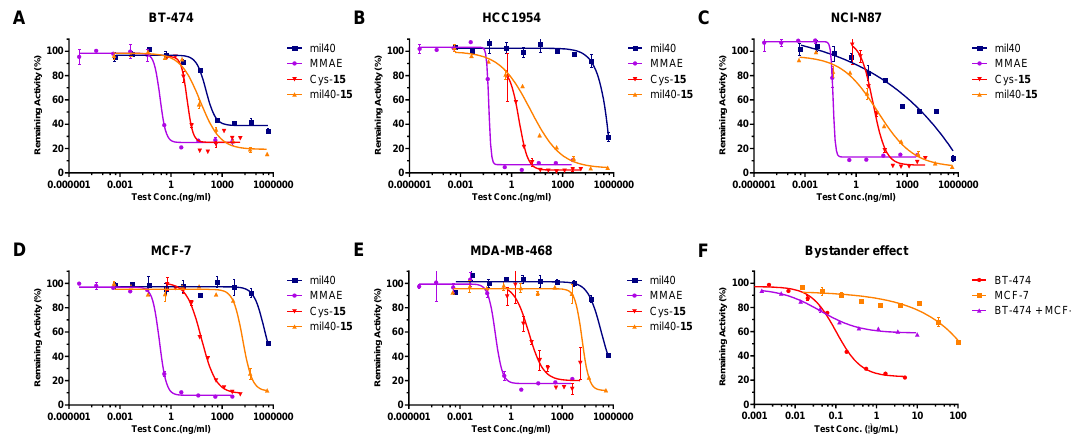
Figure 4. Cytotoxicity of the Cys-linker-MMAE-based ADC in tumor cells. ( A ) The cytotoxicity assays performed in BT-474 cell line. ( B ) The cytotoxicity assays performed in HCC1954 cell line. ( C ) The cytotoxicity assays performed in NCI-N87 cell line. ( D ) The cytotoxicity assays performed in MCF-7 cell line. ( E ) The cytotoxicity assays performed in MDA-MB-468 cell line. ( F ) The bystander effect test performed in BT-474 and MCF-7 cell lines. The results are shown as the mean ± SD from triplicate experiments. Table 2. Cytotoxicity of the Cys-linker-MMAE-based ADC in cancer cell lines in vitro. Cell Lines